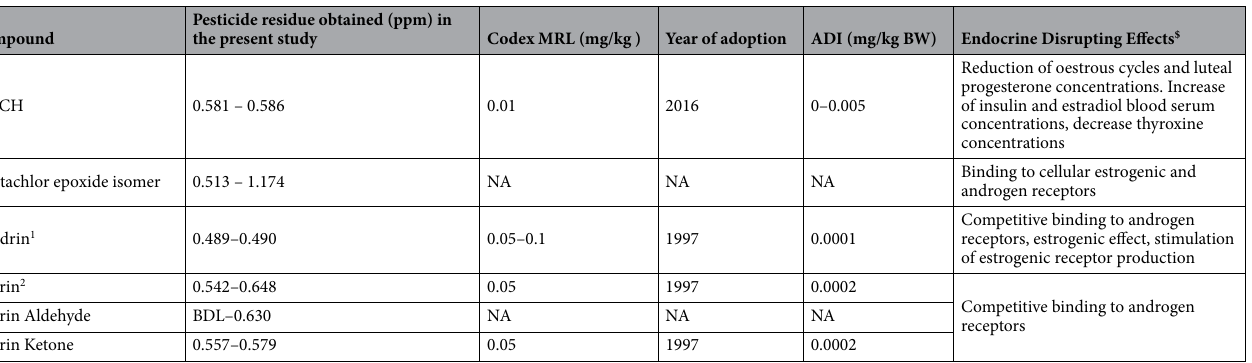
Table 2. Maximum Residue Levels (MRLs) * for the OCP residues in plant samples. Source: http:// www. fao. org/ fao- who- codex alime ntari us/ stand ards/ pestr es/ en/ (accessed on 09.03.2017). *MRLs as adopted by the Codex Alimentarius Commission up to and including its 39 th Session (July 2016). MRLs mentioned are for straw / stems, and these are based on extraneous residues. $ Source: Munif et al. (2011). 1 0.05 mg/kg is for leafy vegetables, and 0.1 mg/kg is for root and tuber vegetables. 2 for Fruiting vegetables. ADI acceptable daily intake, BW body